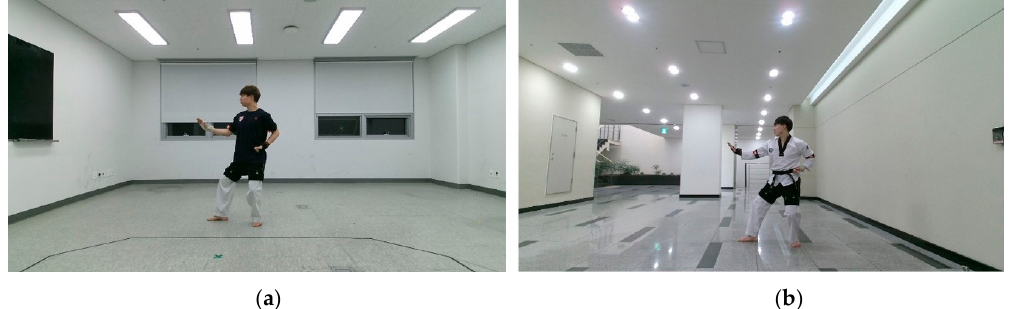
Figure 3. Two image capture environments: ( a ) 70% of the dataset images recorded here; ( b ) the remaining 30% recorded here.